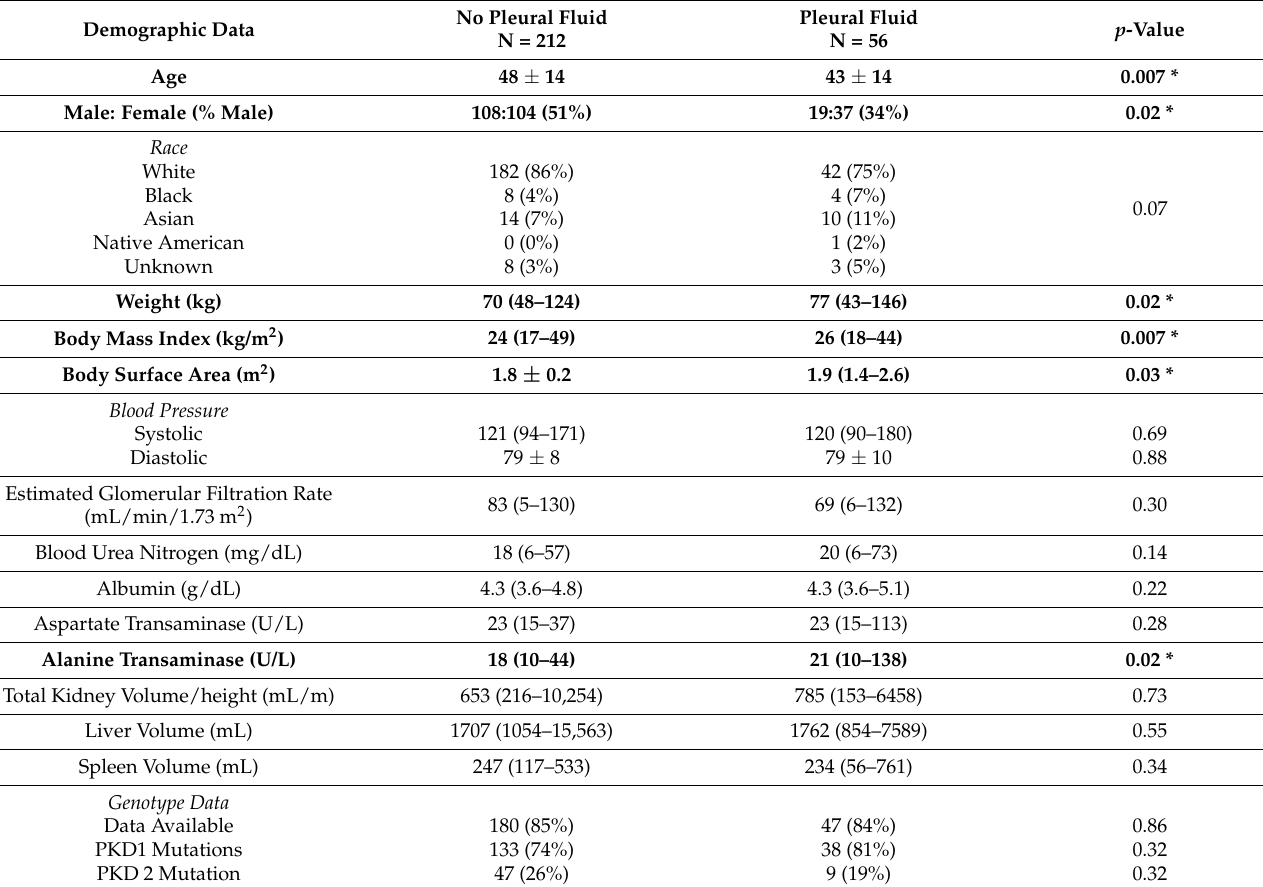
Table 3. Demographic and laboratory data in 268 ADPKD subjects, with and without pleural fluid. Continuous variables are given as mean ± standard deviation. Ordinal variables are shown as number followed by the